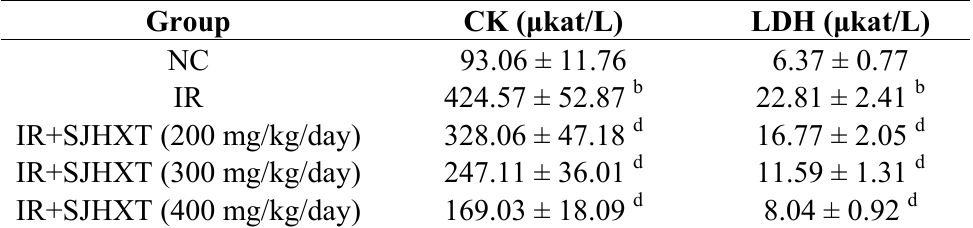
Table 2. Effect of SJHXT on serum CK and LDH activities.